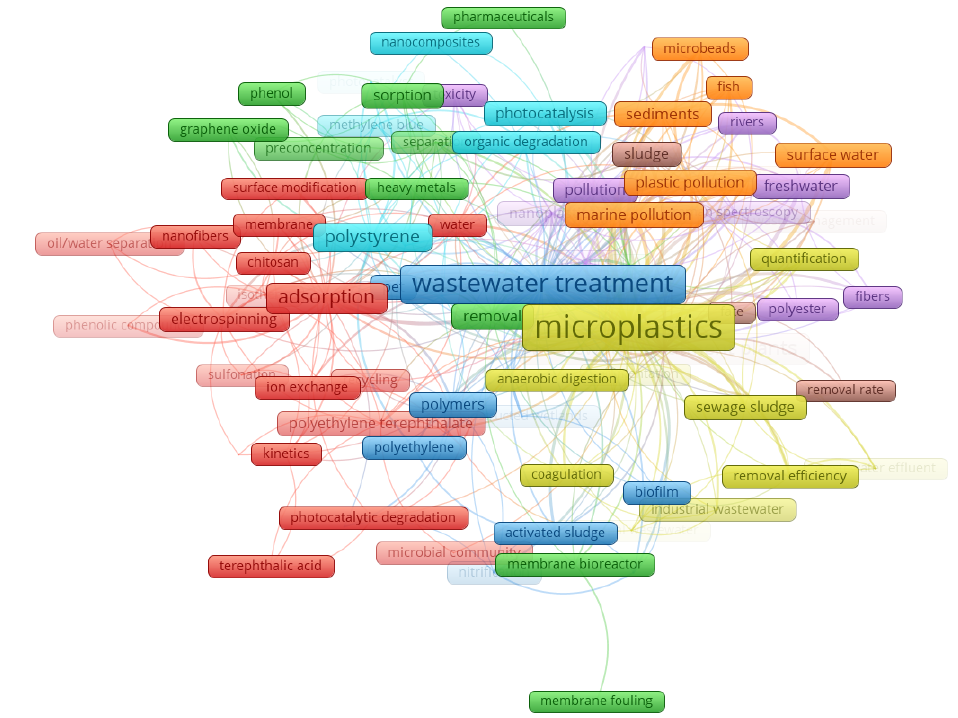
Figure 5. Co-occurrence map of the KWs with minimum occurrence of 5 in the articles derived from the query Q2. The size of the frames is correlated to the occurrence of the related KWs; colors refer to the different clusters with which each item is associated. An interactive visualization of the map is available at https://bit.ly/3y00xaa, (in which the label_ frames can be selected). Accessed date: 30 May 2021.